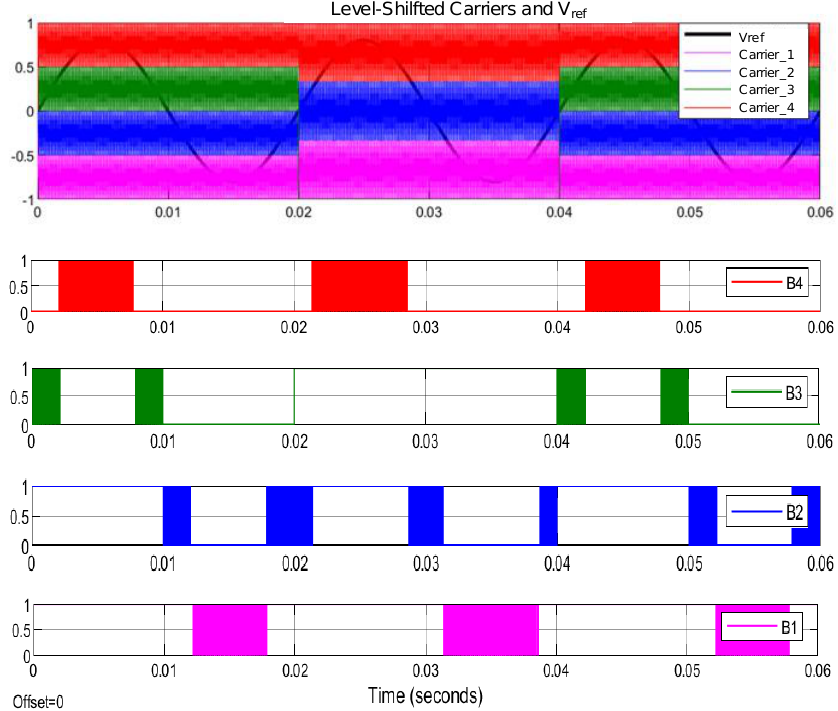
Figure 19. Reconfiguration of a four level-shifted carriers system. The output voltage waveform of the investigated inverter during reconfiguration process is shown in Figure 20.